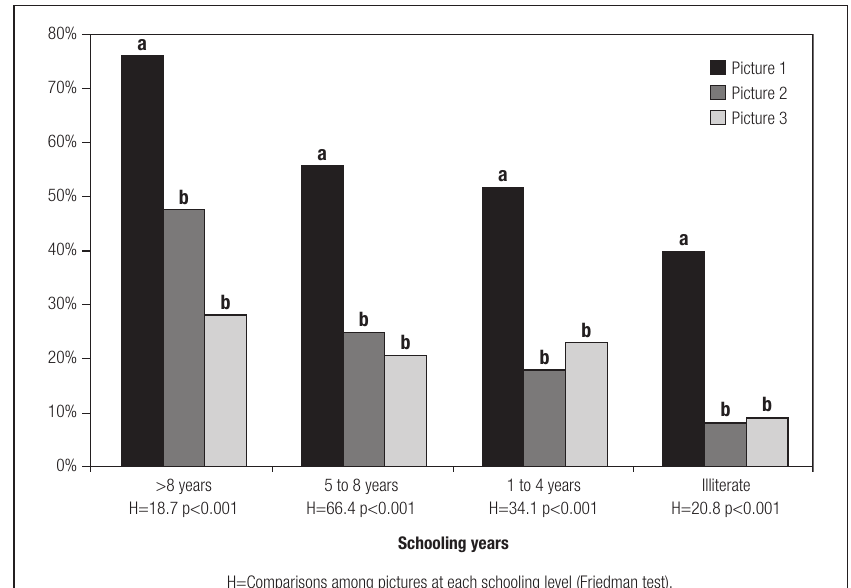
Figure 3. Visual reproduction of geometrical pictures of increasing complexity by individu- als aged 60-92 years, according to schooling